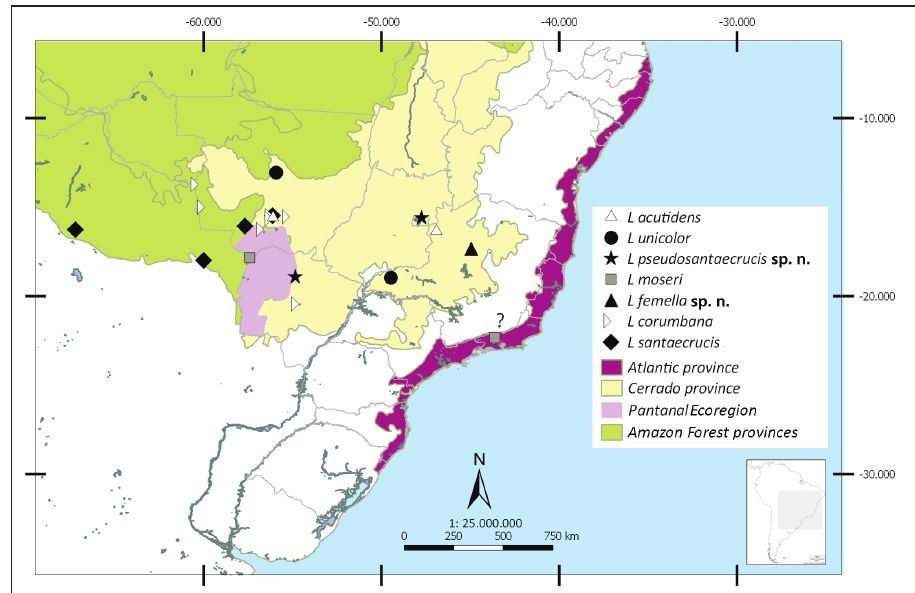
Figure 93. Distribution records of seven species of Liogenys . Biomes based on Morrone